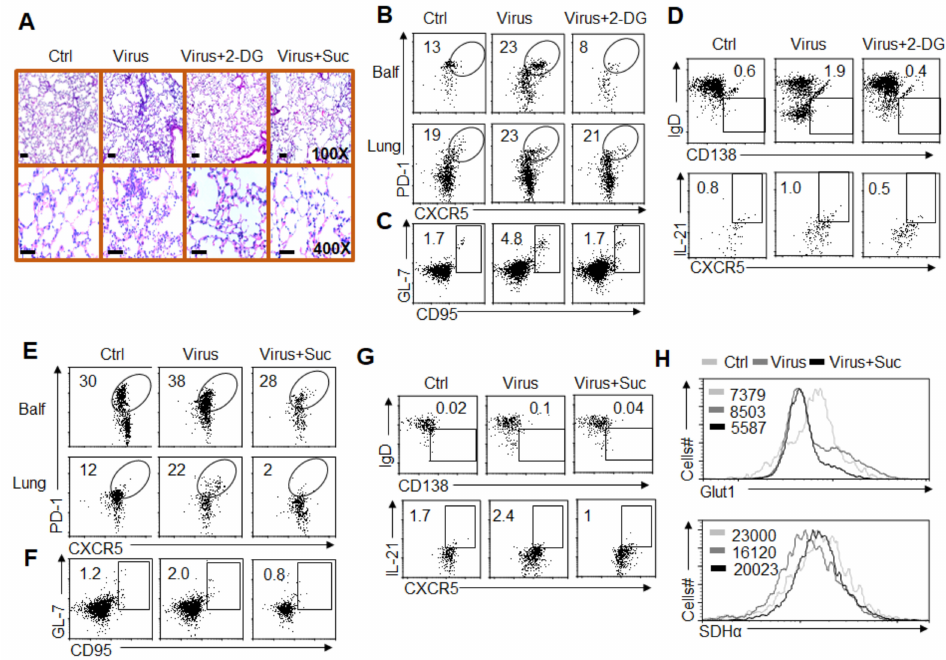
Figure 7. Alterations of glycolysis and OXPHOS signaling control T FH cell di ff erentiation upon PR8 infection. ( A ) Hematoxylin and eosin (H&E) histological staining of lung sections for general pathology and inflammatory cell infiltration at 8 days after PR8 infection and 2-DG (200 mg / kg / day) or succinate (Suc, 70 mg / kg / day) i.p. treatment. ( B ) Flow cytometry of T FH cells in BALF and lung tissue from PR8-infected mice at 8 days in the presence of 2-DG treatment. ( C , D ) Flow cytometry of GC B cells ( C ), plasma cells and IL-21 + T FH cells ( D ) in lungs from PR8-infected mice at 8 days in the presence of 2-DG treatment. ( E ) Flow cytometry of T FH cells in BALF and lungs from WT mice at 8 days after PR8 infection and succinate treatment. ( F , G ) Flow cytometry of GC B cells ( F ), plasma cells and IL-21 + T FH cells ( G ) in lungs from WT mice at 8 days after PR8 infection and succinate treatment. ( H ) Flow cytometry analysis of the MFI of Glut1 and SDH α expression in CXCR5 + PD1 + CD4 + T FH cells in lungs. Data are representative of four individual experiments (n = 4–7 mice per